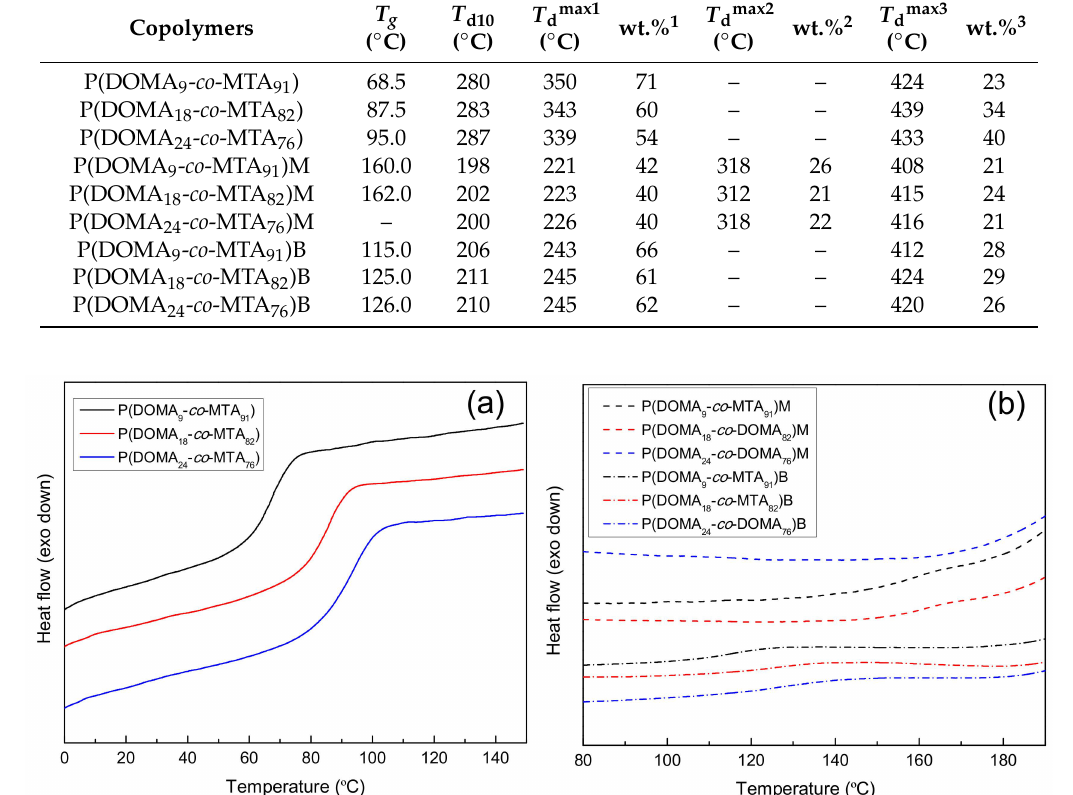
Figure 2. DSC curves of ( a ) P(DOMA x - co -MTA y ) copolymers and ( b ) P(DOMA x - co -MTA y )M and P(DOMA x - co -MTA y )B cationic